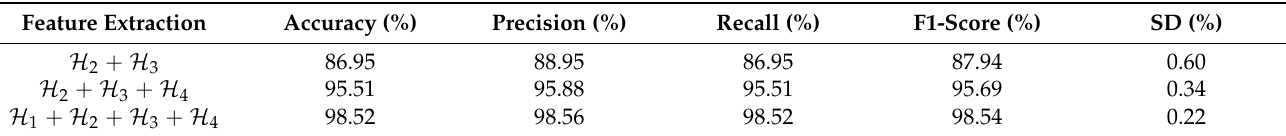
Table 9. Performance comparison of ablation test of different feature combinations in 40 double-hand dynamic ASL